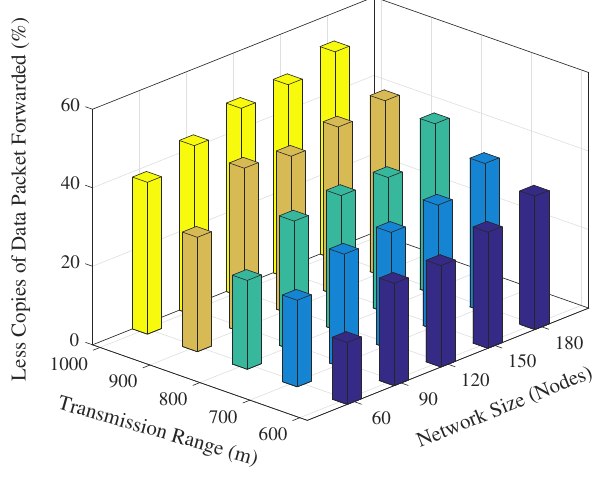
Figure 7. Data packet forwarding load reduced by EDOVE compared to